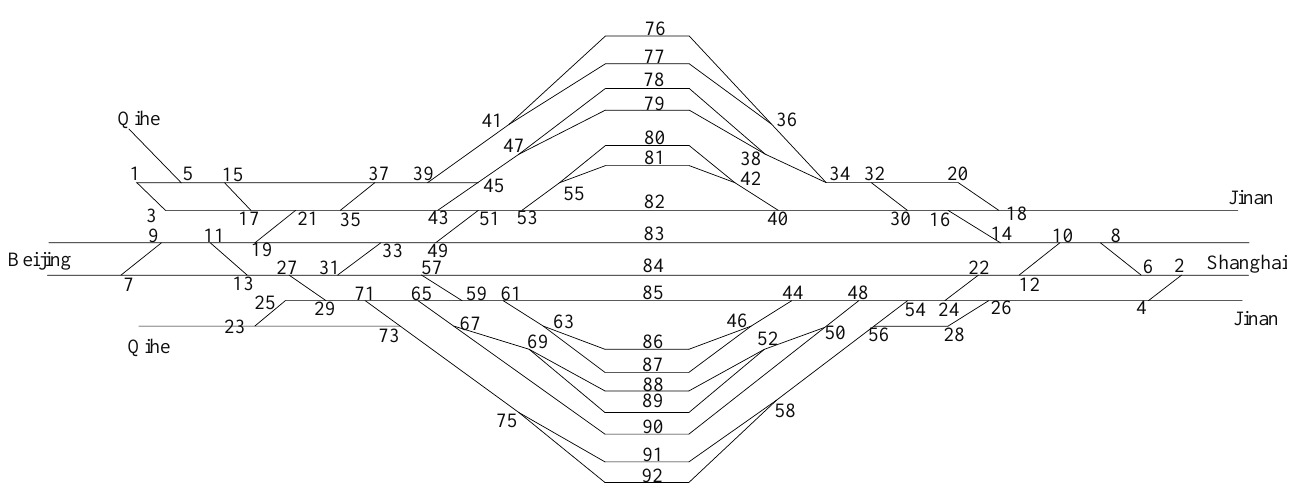
Figure 3. Station layout of Jinanxi Railway Station.